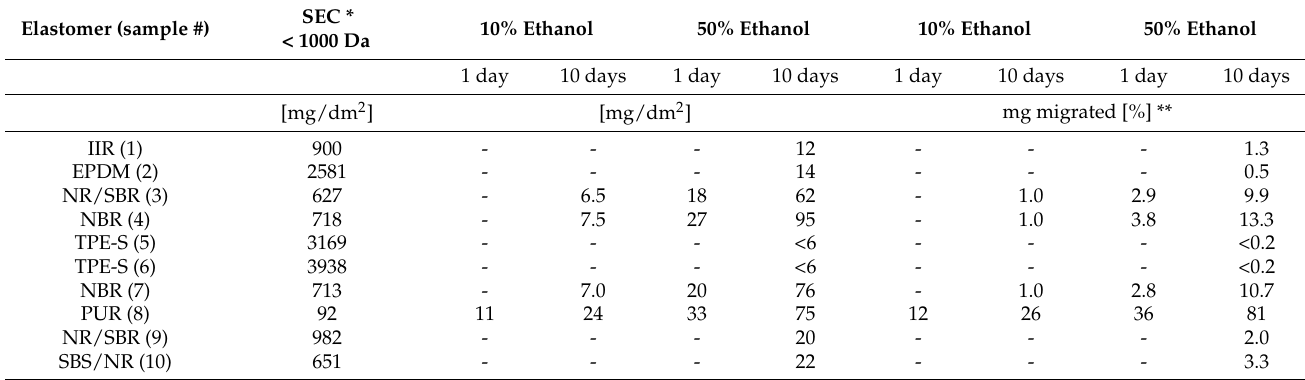
Table 3. Content of substances under 1000 Da in ethanol/water migrats determined by size exclusion chromatography-evaporative light scattering detection